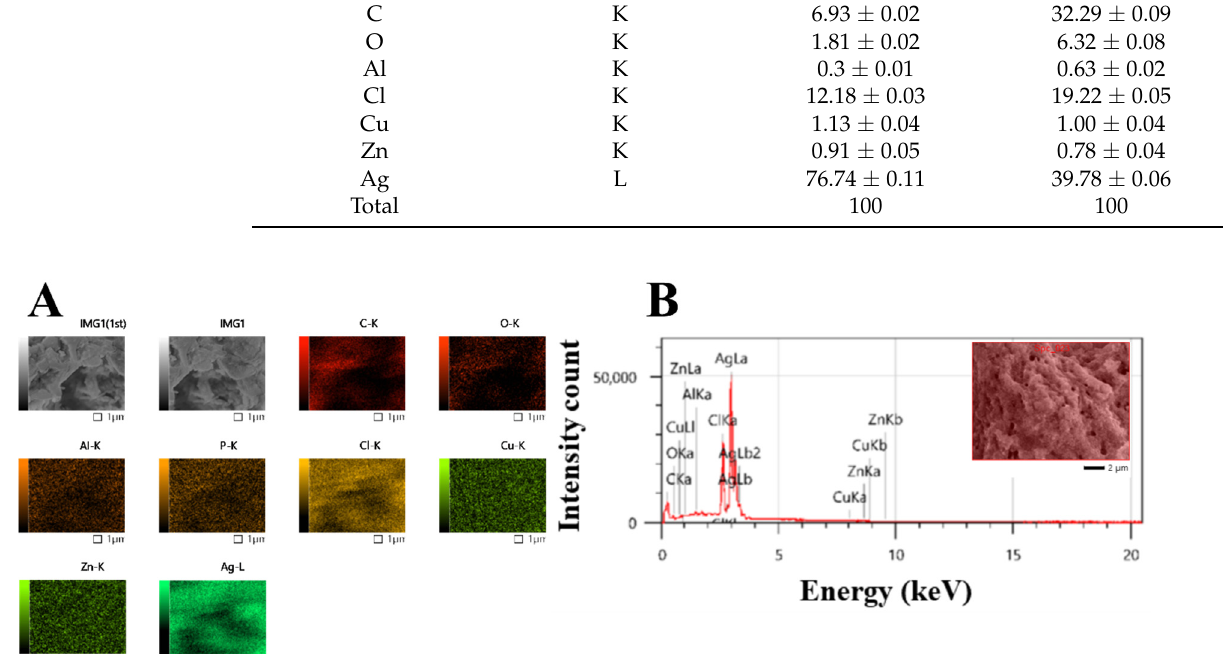
Figure 7. Map ( A ) and EDx ( B ) analysis of Uv@Ag-NPs synthesised from the unicellular ulvophyte sp. MBIC10591. Table 2. EDx analysis of Uv@Ag ‐ NPs synthesised from the unicellular ulvophyte sp. MBIC10591. Element